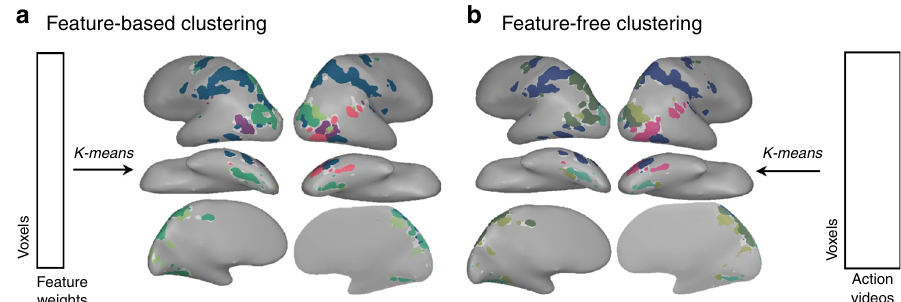
Fig. 4 Generality of the large-scale structure. We compared the results of clustering voxels based on the feature weights fi t by the encoding models ( a ) and by the raw activation patterns across all 60 videos ( b ). The 5-network solutions over data from video set 1 are shown for both clustering analyses. Parts of cortex with similar colors had either similar feature weights ( a ) or similar overall response pro fi les ( b ). Each cluster ’ s color was assigned algorithmically such that clusters with similar response pro fi les were similar in hue and were determined separately for ( a ) and ( b ). All brain fi gures were created by the